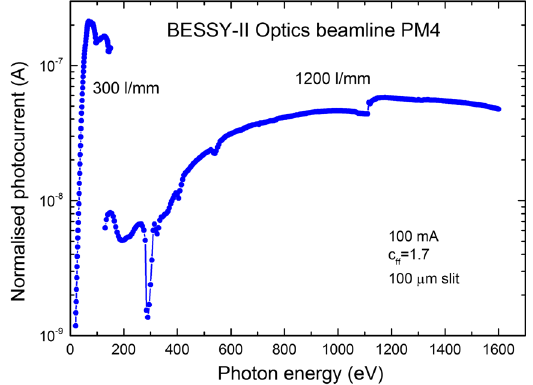
FIG. 15. Scan of normalized detector response of the incident beam (with no sample) vs energy, using the low and the high energy monochromator, with θ 2 ¼ ϕ ¼ 0 .